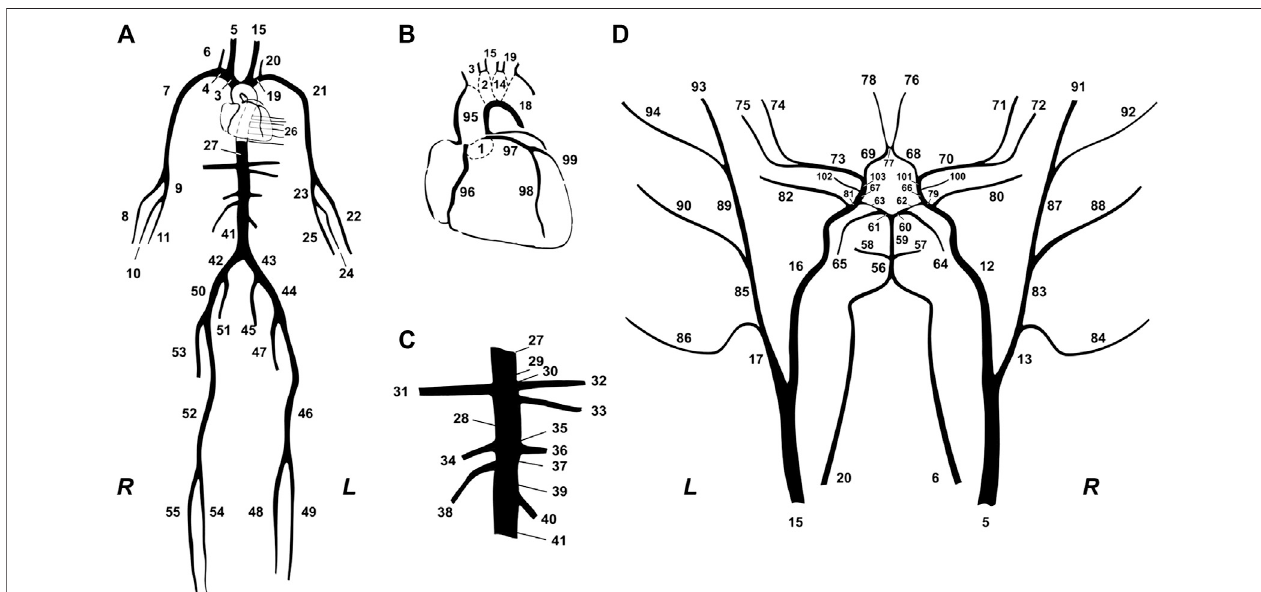
FIGURE 1 | Schematic representation of the model of systemic circulation developed by (Reymond et al., 2009). (A) Main systemic arterial tree. (B) Detail of the aortic arch and the coronary network. (C) Detail of the principal abdominal aorta branches. (D) Blown-up schematic of the detailed cerebral arterial tree, which is connected via the carotids (segments 5 and 15) and the vertebrals (segments 6 and 20) to the main arterial tree shown in (A) .